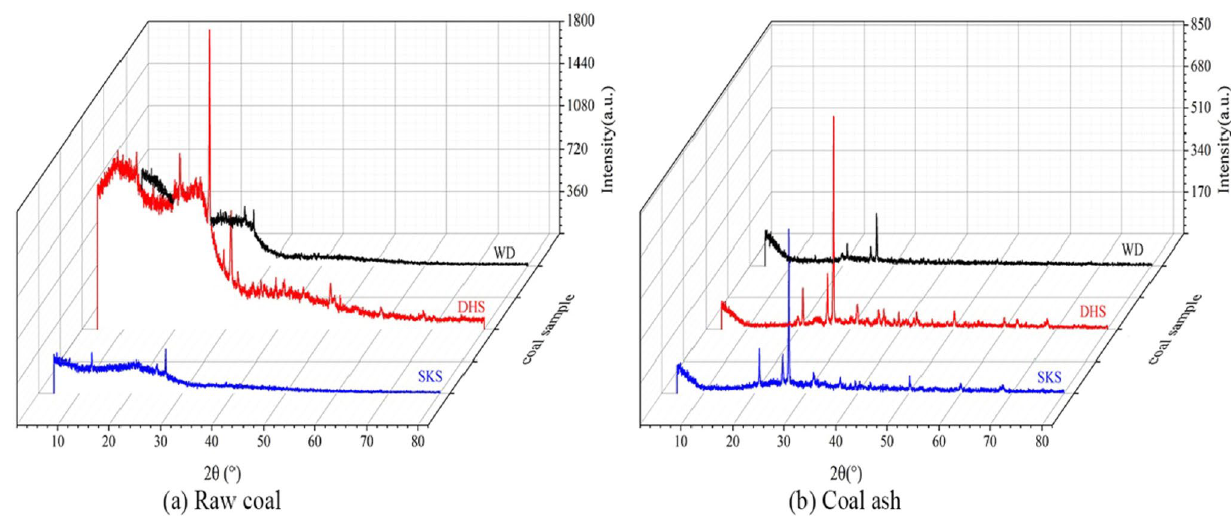
Fig. 4 XRD spectra of raw coal ( a ) and coal ash ( b